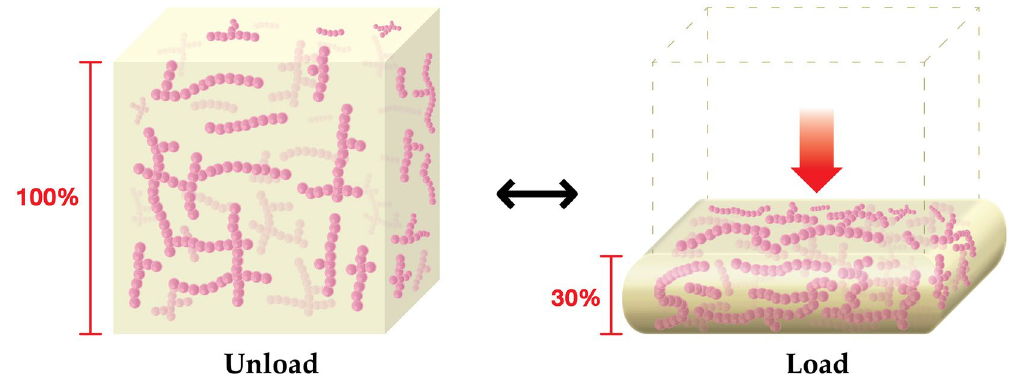
Figure 5. Unloaded (left) and loaded at z–direction (right) models of rubber foam samples. Unloaded rubber molecules (pink lines) have freedom to move, whereas loaded rubber molecules cannot move and rubber foam is expanded at x– and y–directions due to the compression. The model was drawn using Adobe illustrator software vision 24.2.3 40